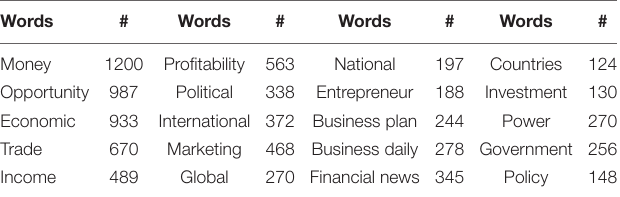
TABLE 2 | Topics extracted from the crawled news.